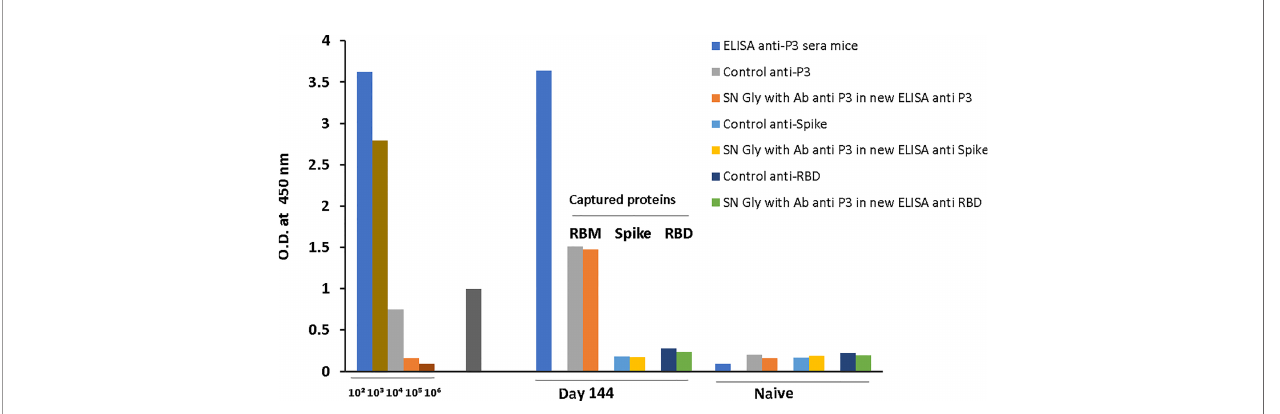
FIGURE 4 | Cross-reactivity of S and RBD with ELISA captured RBM 436-507 . ELISA captured mice anti-RBM 436-507 antibodies were eluted with Gly pH 2.5 and used to determine the reactivity with RBM (homologous), and with S and RBD (heterologous) antigens ELISA reaction was developed using rabbit anti-mouse alkaline phosphatase